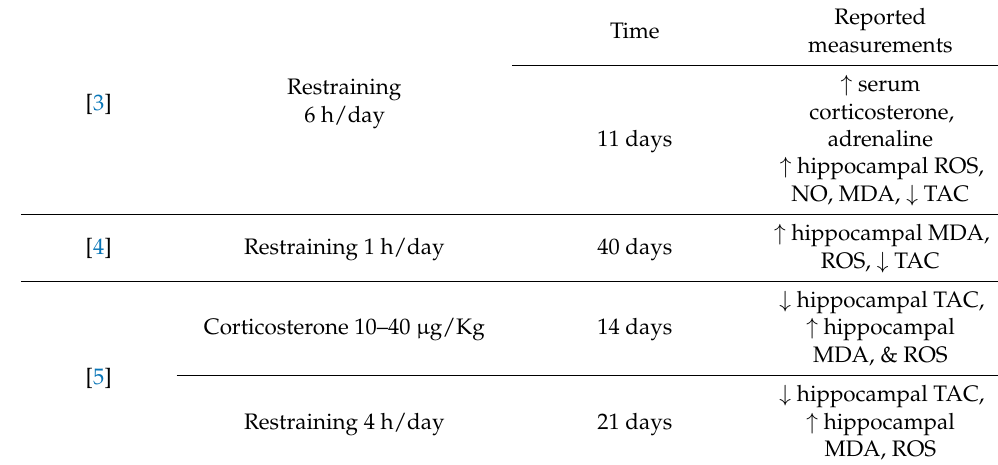
Table 1. Experimental designs of restraint stress based on physical restraining or corticosterone injection in